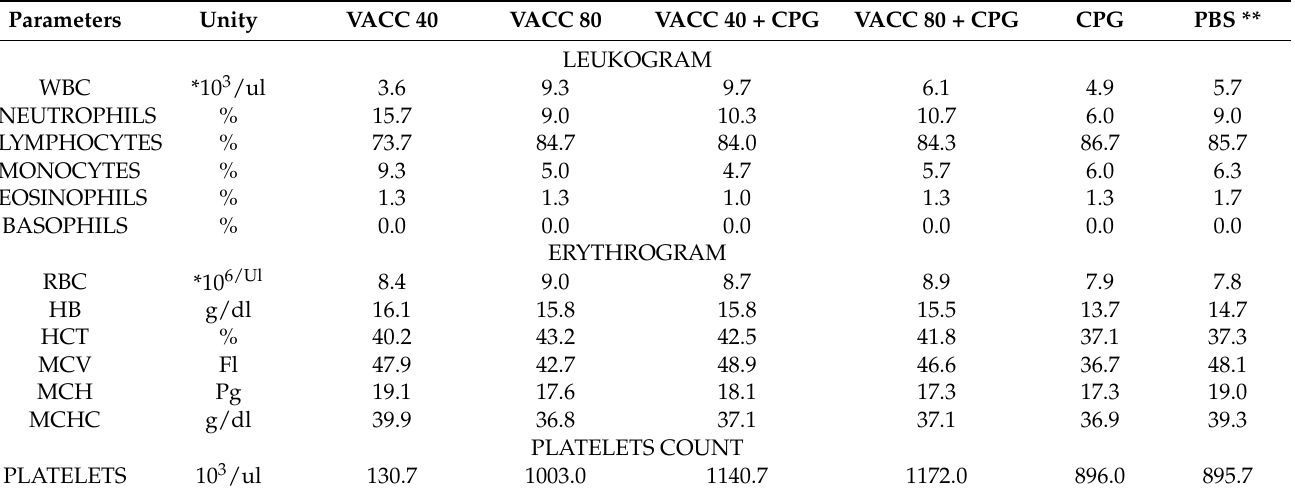
Table 6. Results from Hematological Profiling.